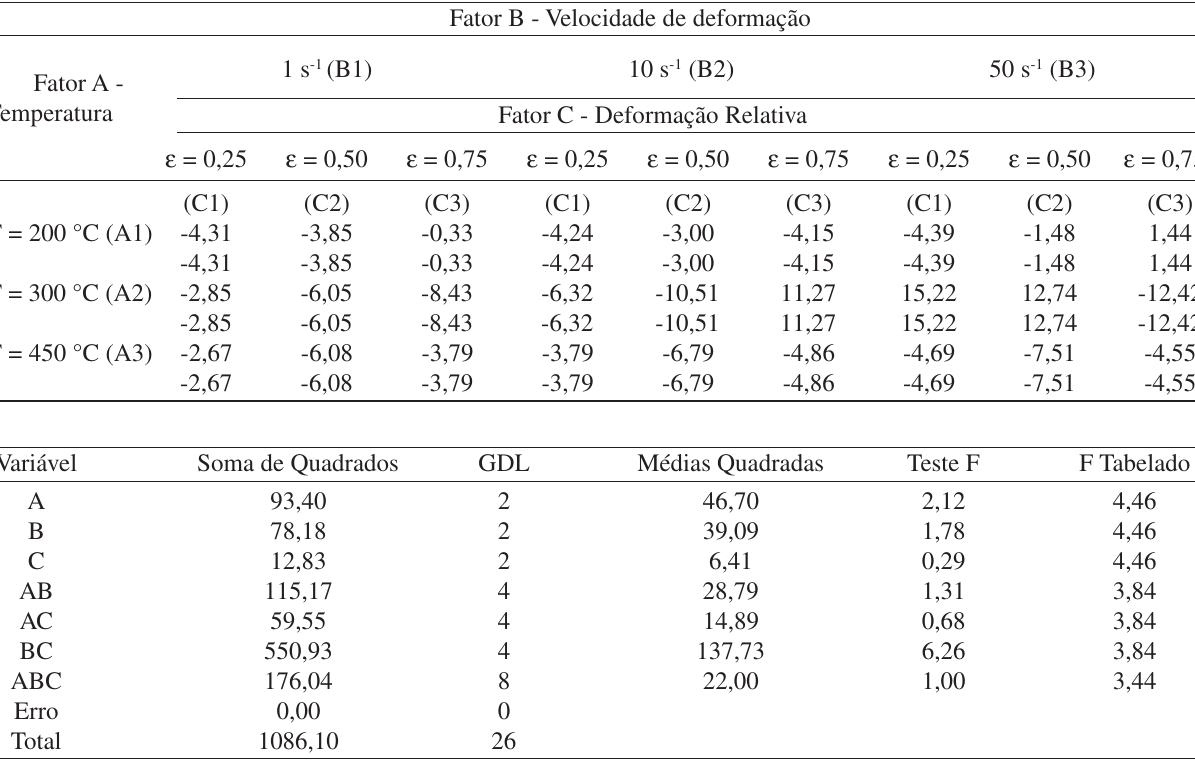
Tabela 2. Dados e tabela ANOVA para o lubrificante “Oildag”. Fator B - Velocidade de